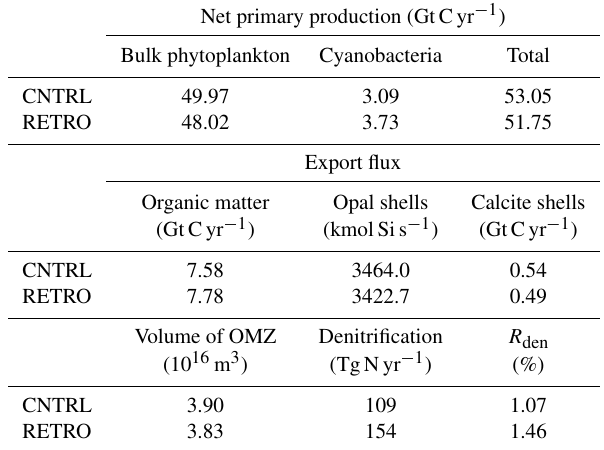
Table 3. Global mean net primary production rate, biogenic material export flux at 100m, volume of oxygen minimum zones (OMZs), global mean denitrification, and ratio of denitrifi- cation to organic matter export flux on a percentage basis ( R den